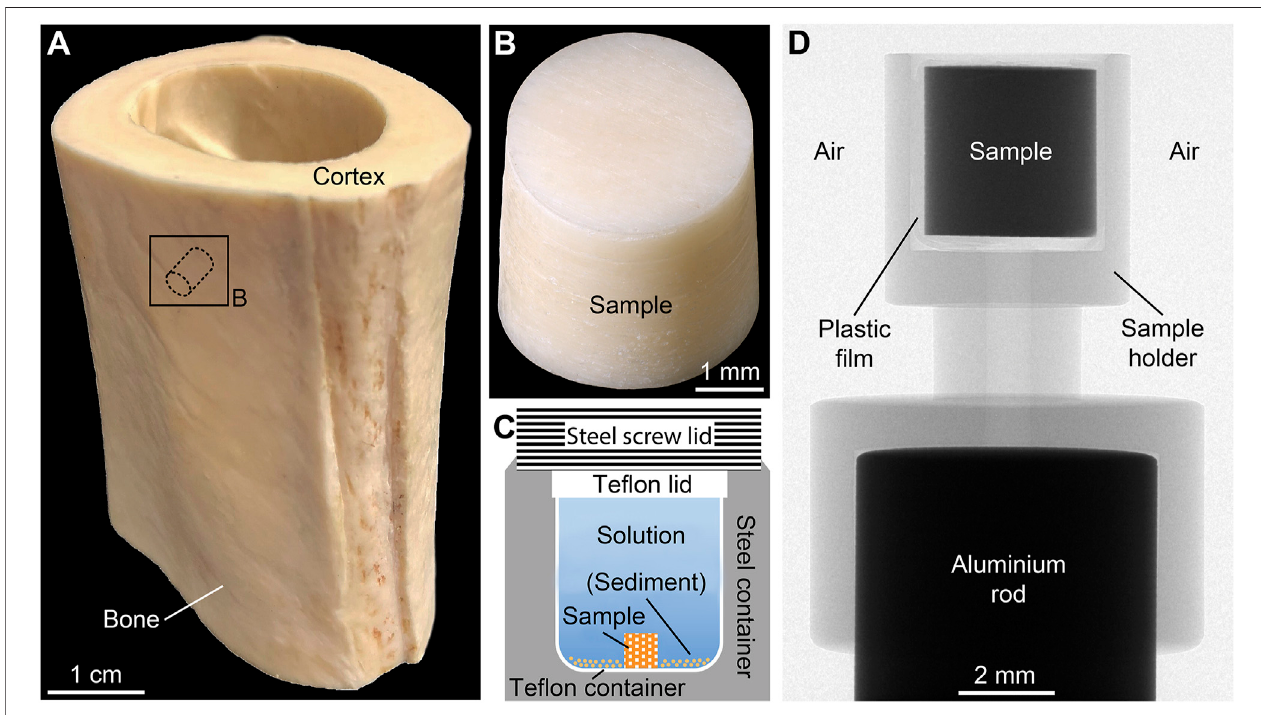
FIGURE 1 | Preparation and micro-computed tomography (µCT) scanning of cortical bone samples. (A) Diaphyseal part of the ostrich tibia with representative samplinglocation. (B) Corticalbonesampledrilledperpendiculartothegrowthdirection. (C) ReactionsteelcontainerwithinnerTe fl oncontainerandsampleposition. (D) X-ray image of the custom-made sample holder used for µCT scanning showing the orientation of the sample.